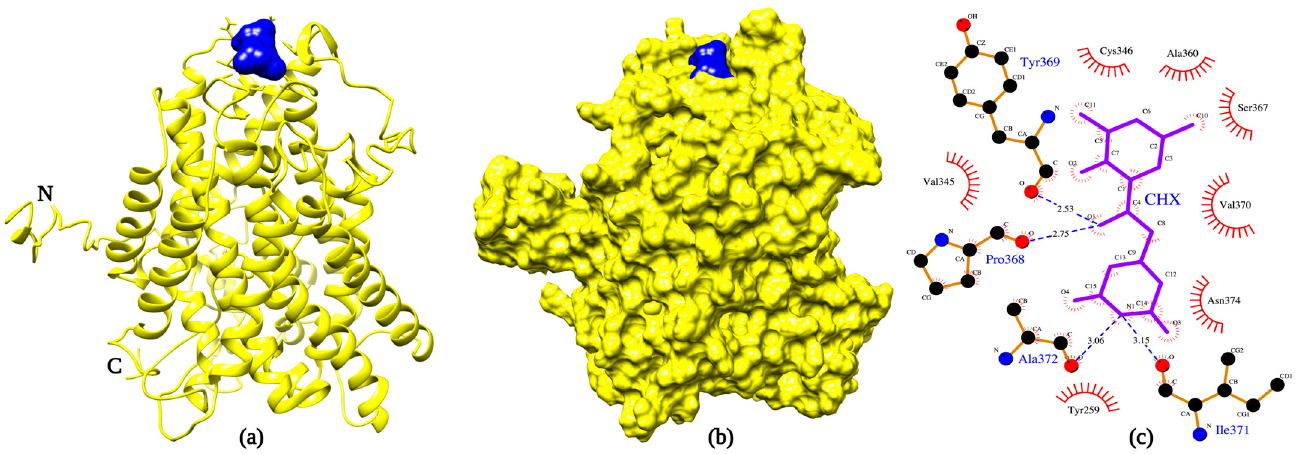
Figure 3. Docked complex structure representing Agp2 bound with CHX. ( a , b ) show the ribbon and surface representation of Agp2 in yellow and CHX in blue. ( c ) Ligplot interaction map of Agp2-CHX